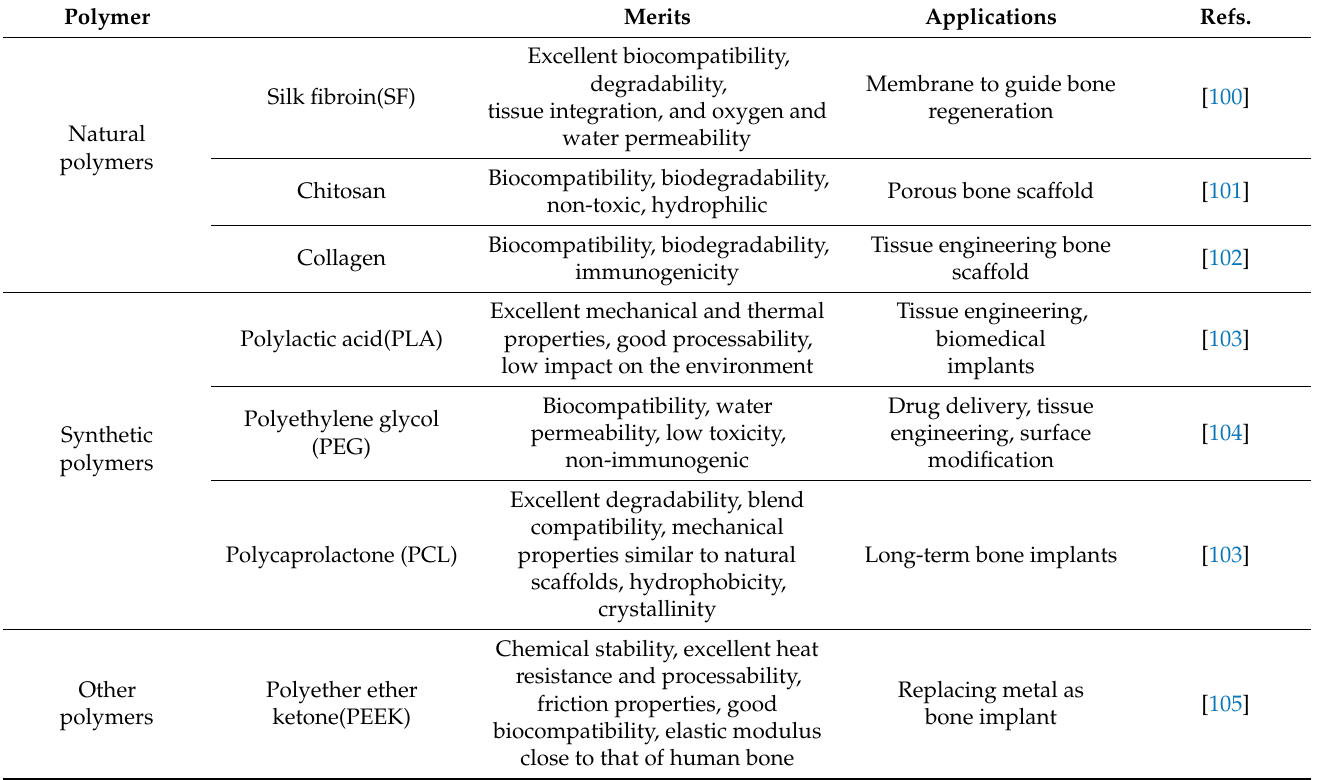
Table 3. Characteristics of common polymers and their applications in bone tissue